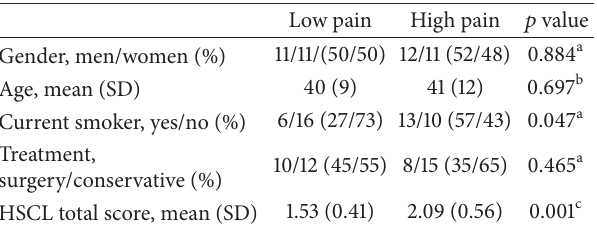
Table 1: Baseline characteristics of patients grouped in the high and low pain group.